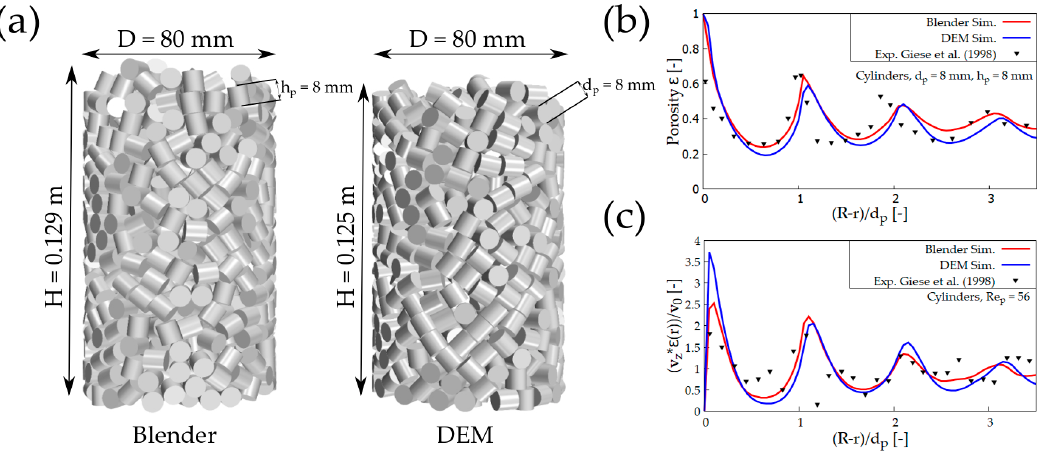
Figure 6. ( a ) Comparison between synthetic generated packing of cylinders, ( b ) radial porosity profiles, and ( c ) velocity profiles. Experiments from Giese et al. [30].